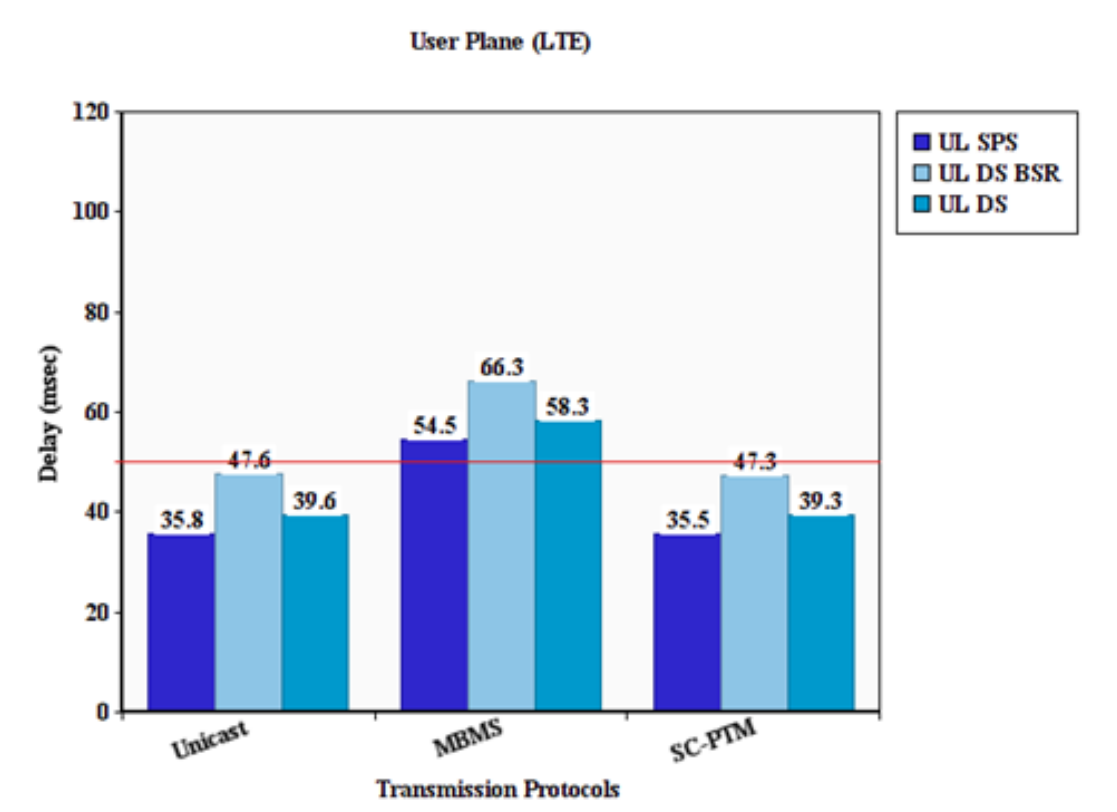
Figure 2. End-to-end (E2E) user plane (UP) latency in LTE-A